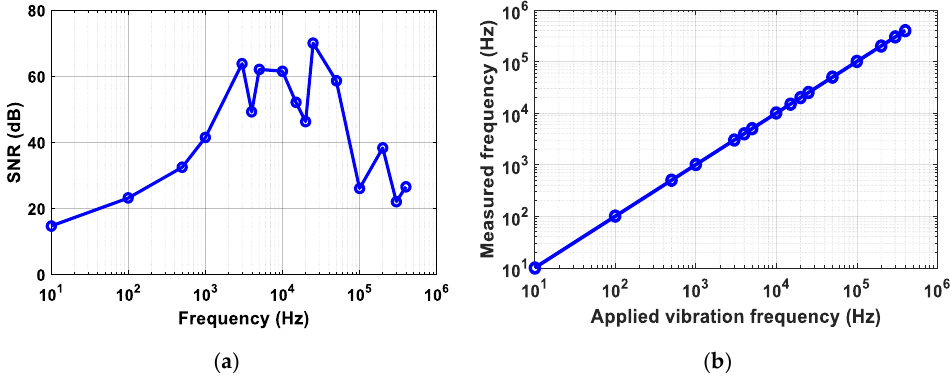
Figure 6. ( a ) Measured SNR as a function of vibration frequency, ( b ) the measured frequencies vs. the applied vibration frequencies from 10 Hz to 400 kHz. the applied vibration frequencies from 10 Hz to 400